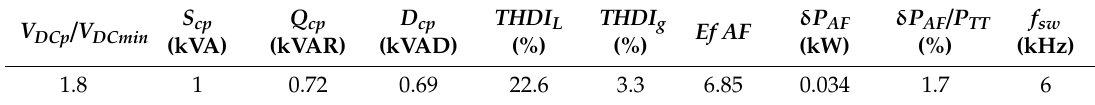
Table 7. The main experimental energetic performances of the non-adaptive control, at reduced load. V DCp / V DCmin